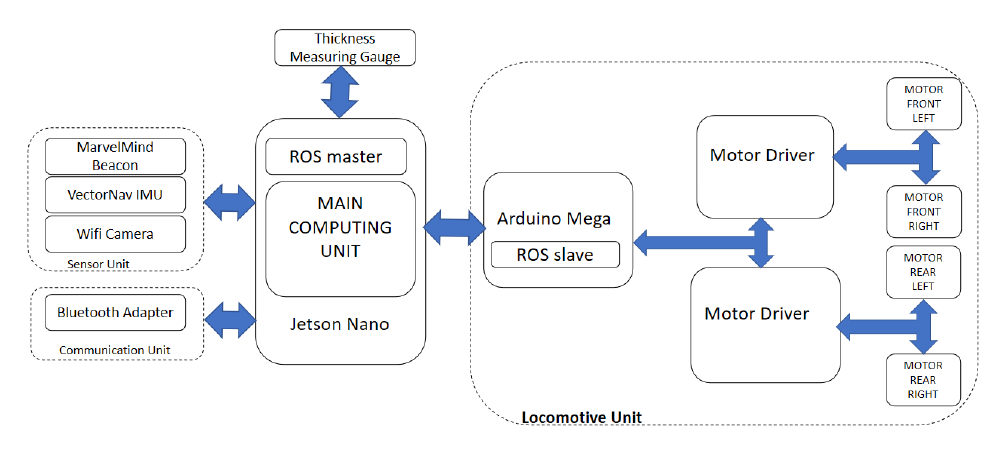
Figure 5. Hardware Architecture of sparrow